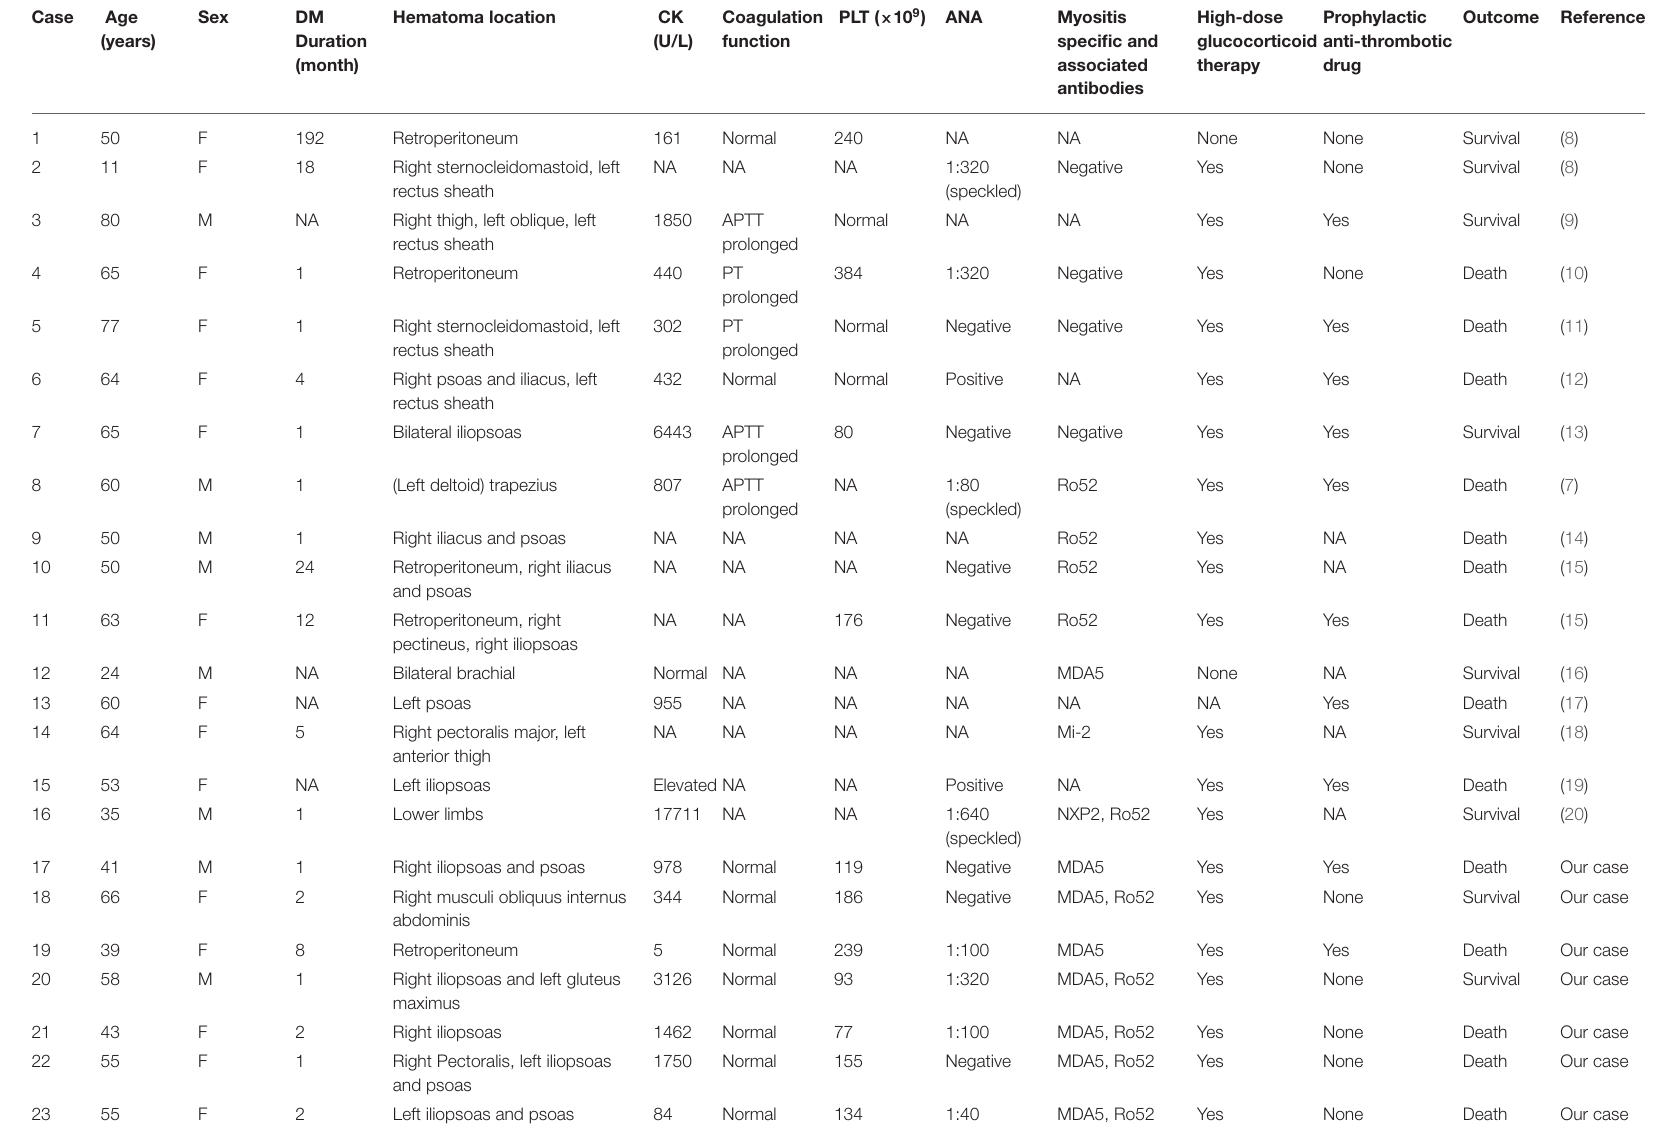
TABLE 1 | Reported cases of spontaneous intramuscular hemorrhage in patients with dermatomyositis in published studies and our cohort.